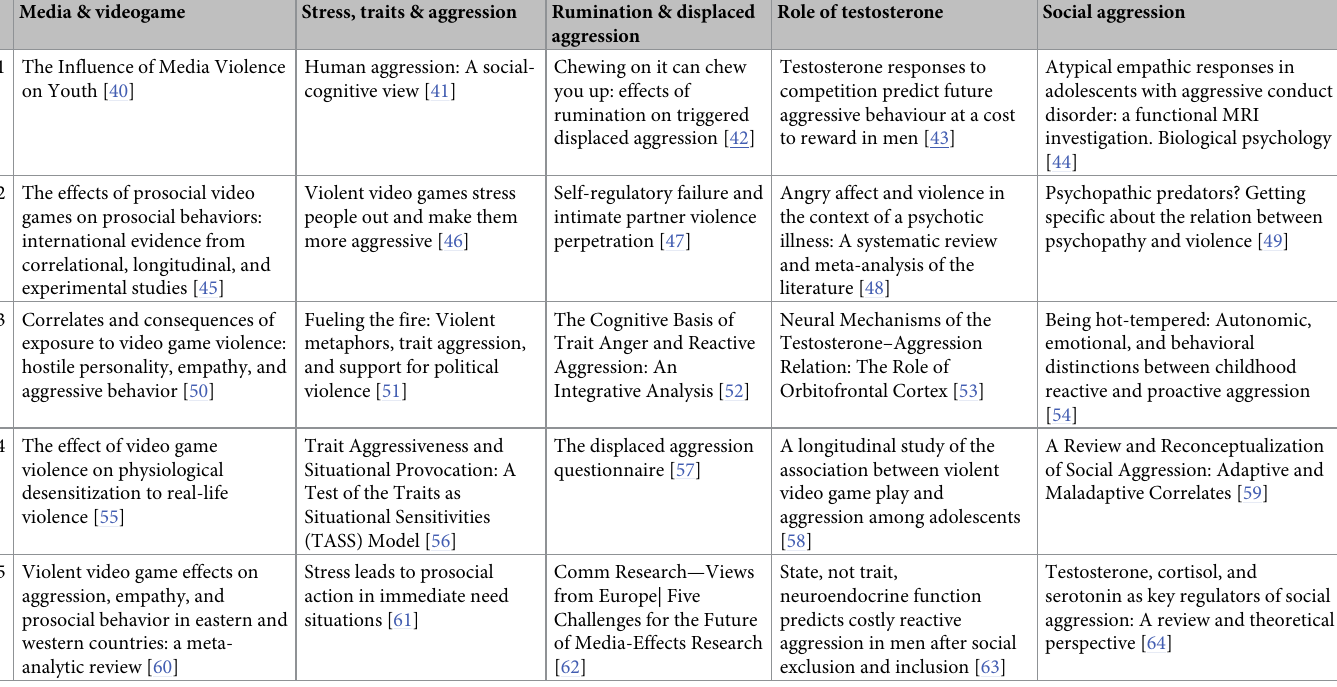
Table 3. Top 5 articles for each of the Top 5 largest communities in the human aggression